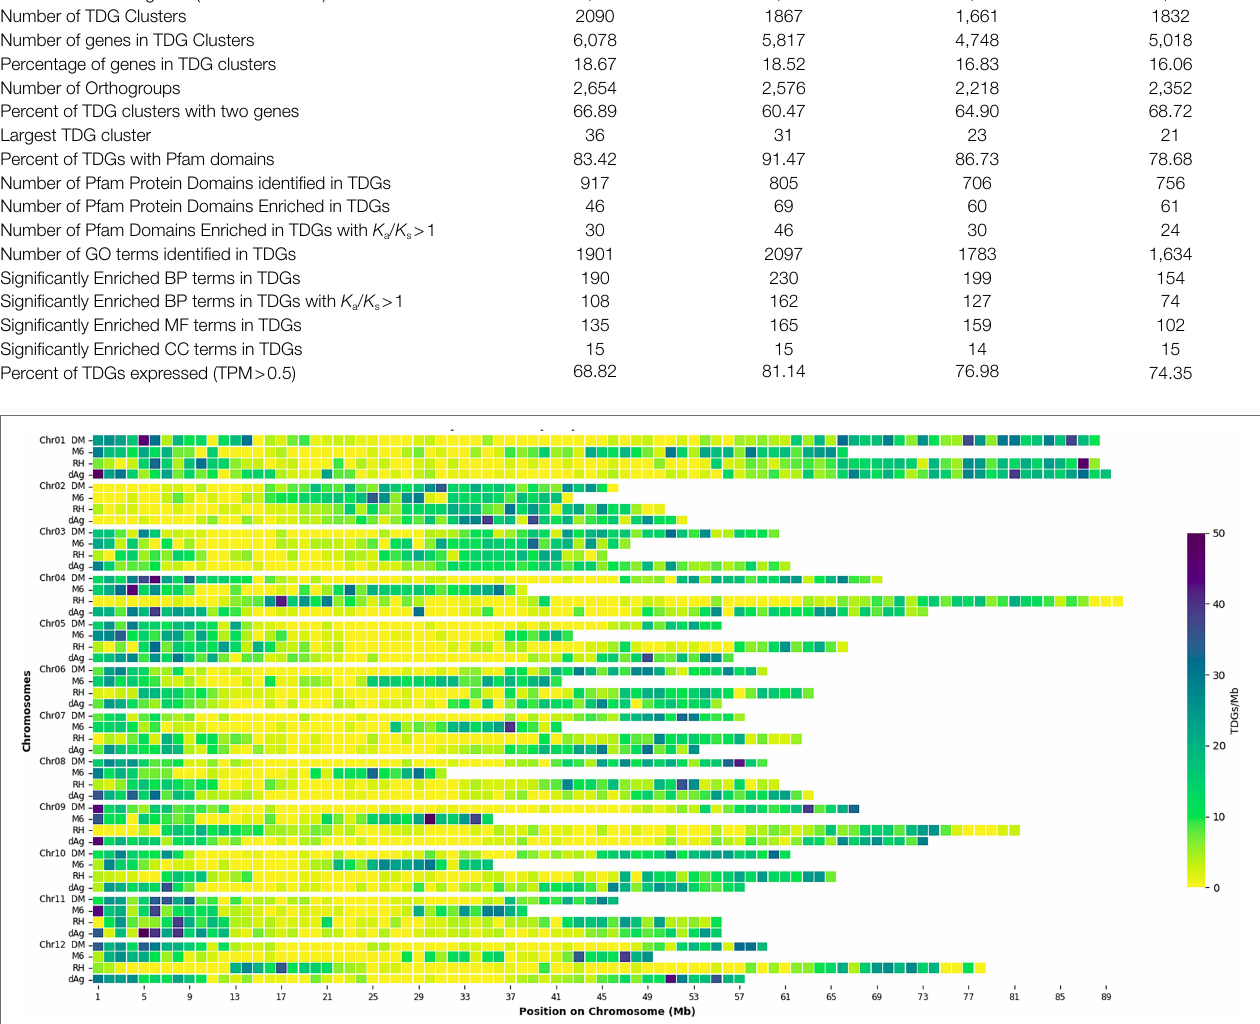
FIGURE 1 | Distribution of density of tandemly duplicated genes per 1 Mb across each potato genome. Square boxes between rows do not correspond to sequence alignment. of 92.97% TDG pairs showed K a / K s < 1.0 (i.e., negative or purifying